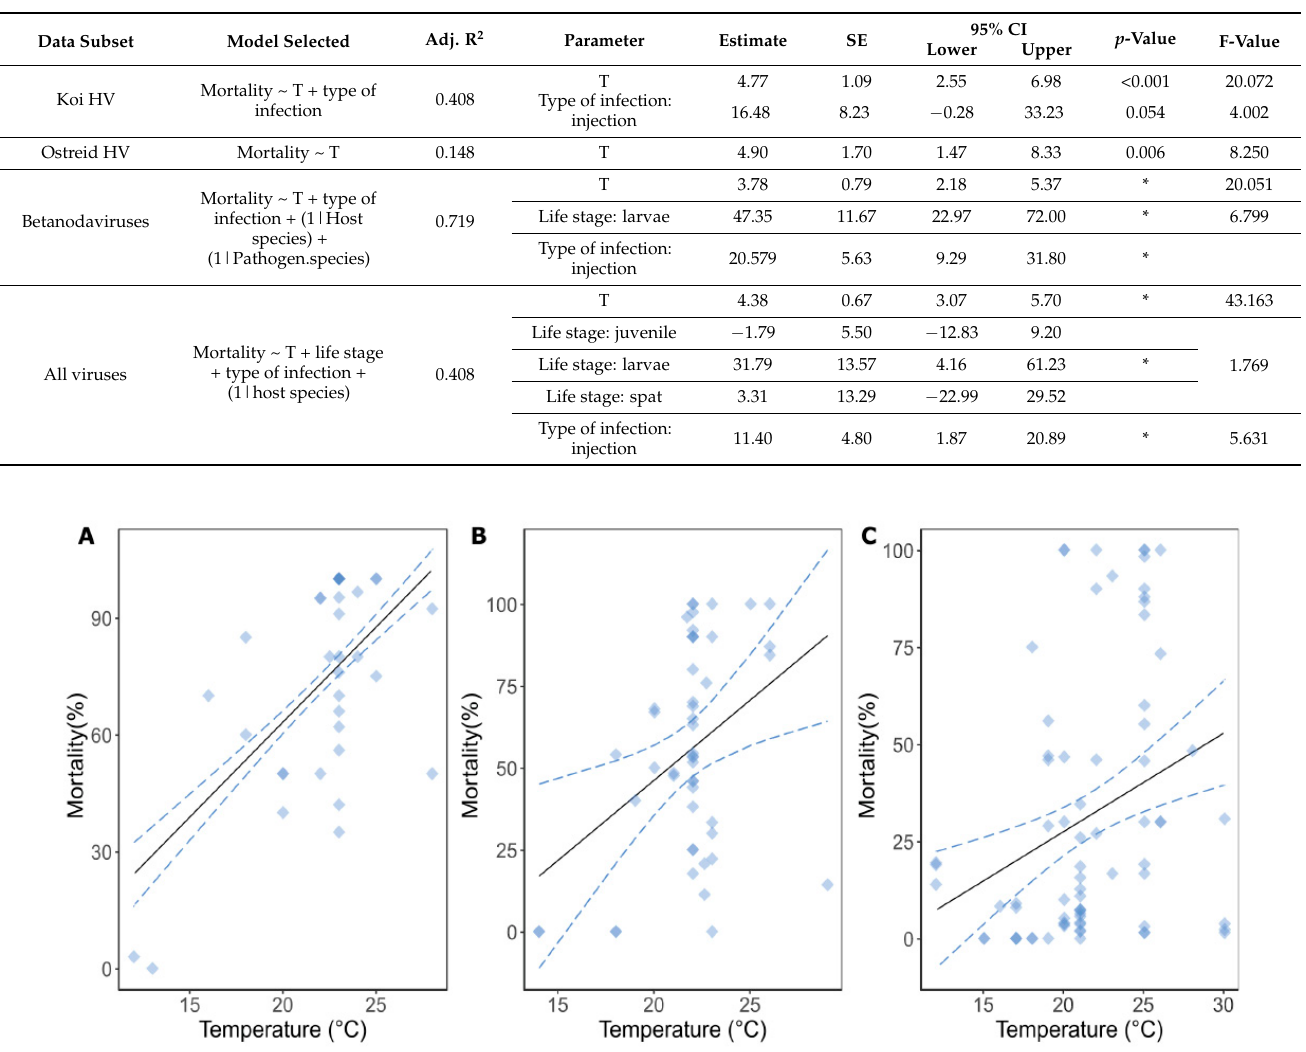
Figure 1. Predicted changes in mortality (%) of reared aquatic animals infected by viral pathogens related to temperature increases. ( A ) Koi Herpesvirus Disease (KHV, CyHV-3, n = 36), ( B ) Ostreid Herpesvirus Disease (OsHV-1, n = 49), ( C ) Betanodaviruses (NVVs, n = 75). Dots represent the raw data extracted from the originally reviewed literature. Solid black lines represent predictions arising from the selected linear and linear mixed models (LM and LMMs, Table 1). The dotted lines represent the 95% confidence intervals of the prediction. Table 1. Details from the selected linear models (LMs) and linear mixed models (LMMs) to test the relationship between aquatic animal mortality and temperature (T) under viral infections. The p - value is provided for LMs to indicate term significance. In LMMs, a term is considered significant when its 95% confidence interval does not include 0, and is indicated by *.